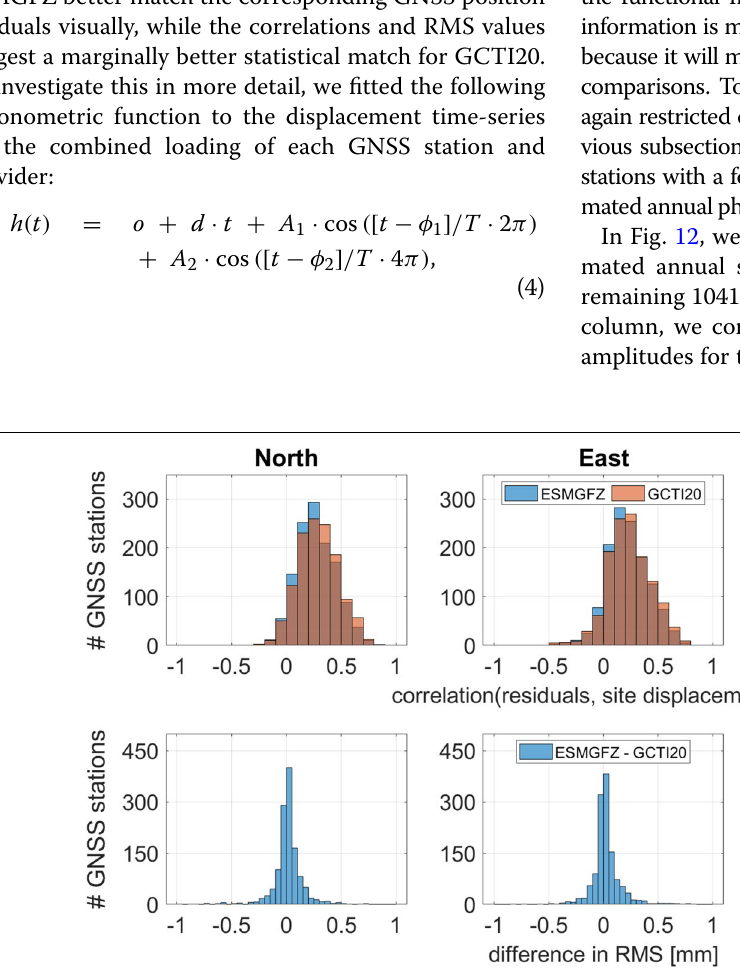
Fig. 11 Top row: histograms of the correlations between GNSS position residuals and the corresponding (24 h average) site displacements for the combined (NTAL NTOL HYDL [ SLEL]) non-tidal loading by either GCTI20 or ESMGFZ. Bottom row: histograms of the differences (cid:31) RMS in Eq. + + + (3). Left column: North, middle column: East, right column: up (different scale for (cid:31) RMS